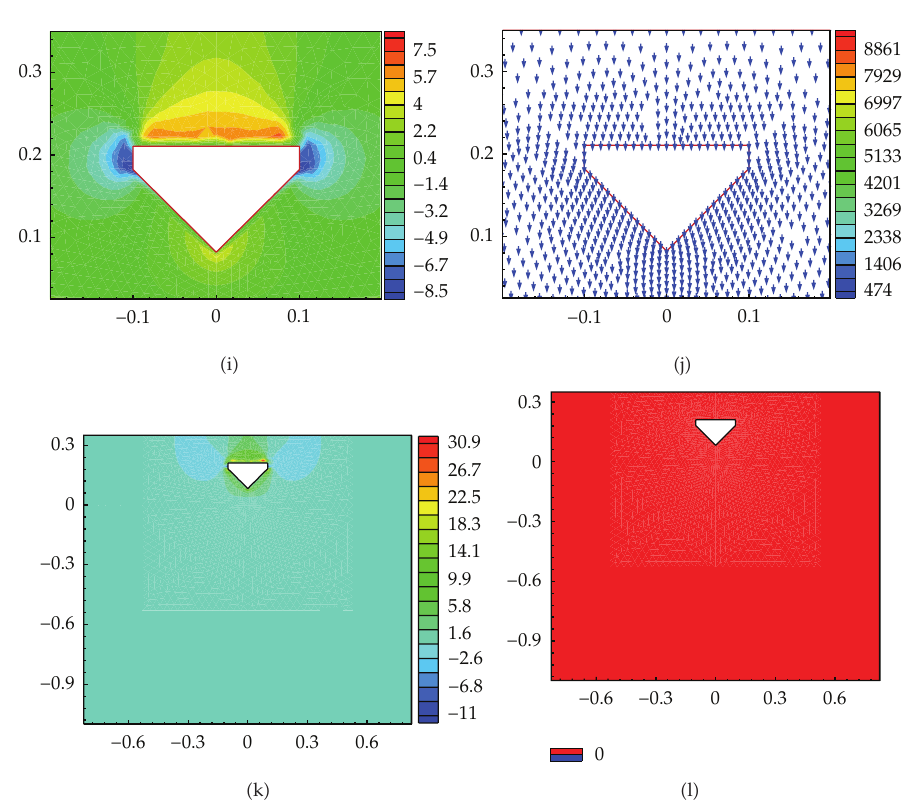
Figure 10: Microscopic details of fluid energy at t (cid:9) 0 . 06s. (cid:2) a (cid:3) free surface profile; (cid:2) b (cid:3) velocity vector; (cid:2) c (cid:3) convection of kinetic energy; (cid:2) d (cid:3) convective vector of kinetic energy (cid:2) high to low (cid:3) ; (cid:2) e (cid:3) work done by pressure; (cid:2) f (cid:3) convective vector of pressure; (cid:2) g (cid:3) work done by gravity; (cid:2) h (cid:3) gravity vector; (cid:2) i (cid:3) convection of potential energy; (cid:2) j (cid:3) convective vector of potential energy; (cid:2) k (cid:3) transient change of kinetic energy; (cid:2) l (cid:3) transient change of potential